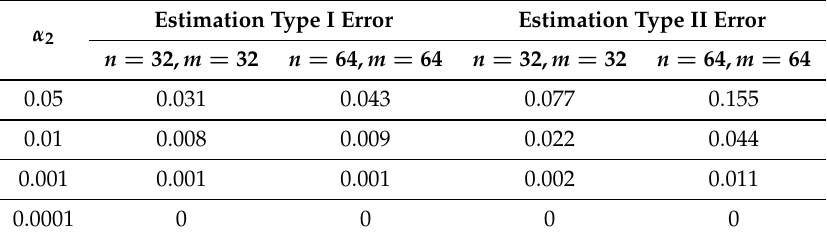
Table 12. Proportion of type I and II errors made by the BIC test. α